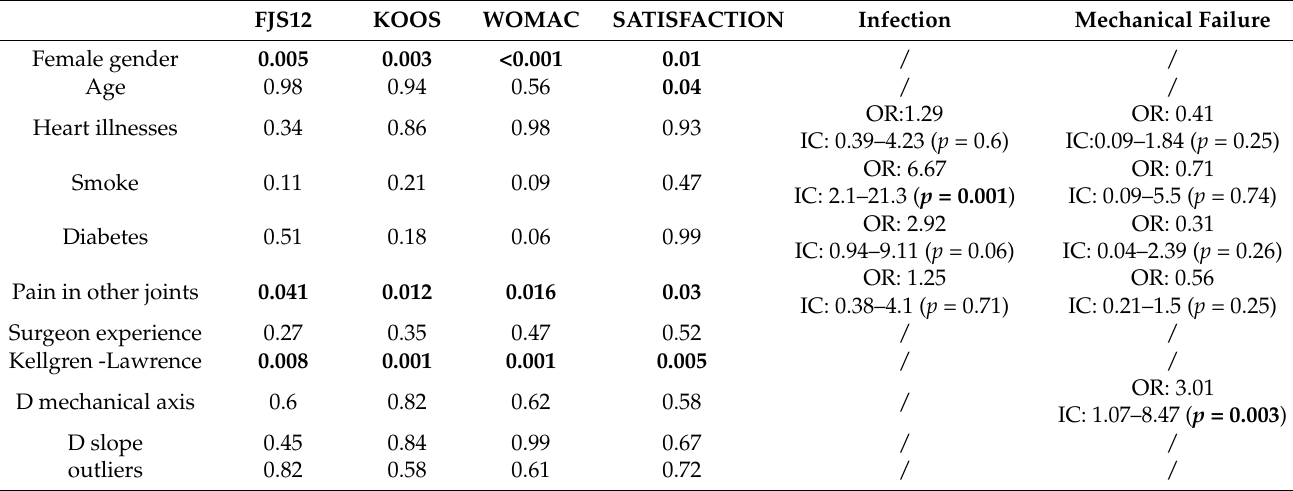
Table 4. Statistic